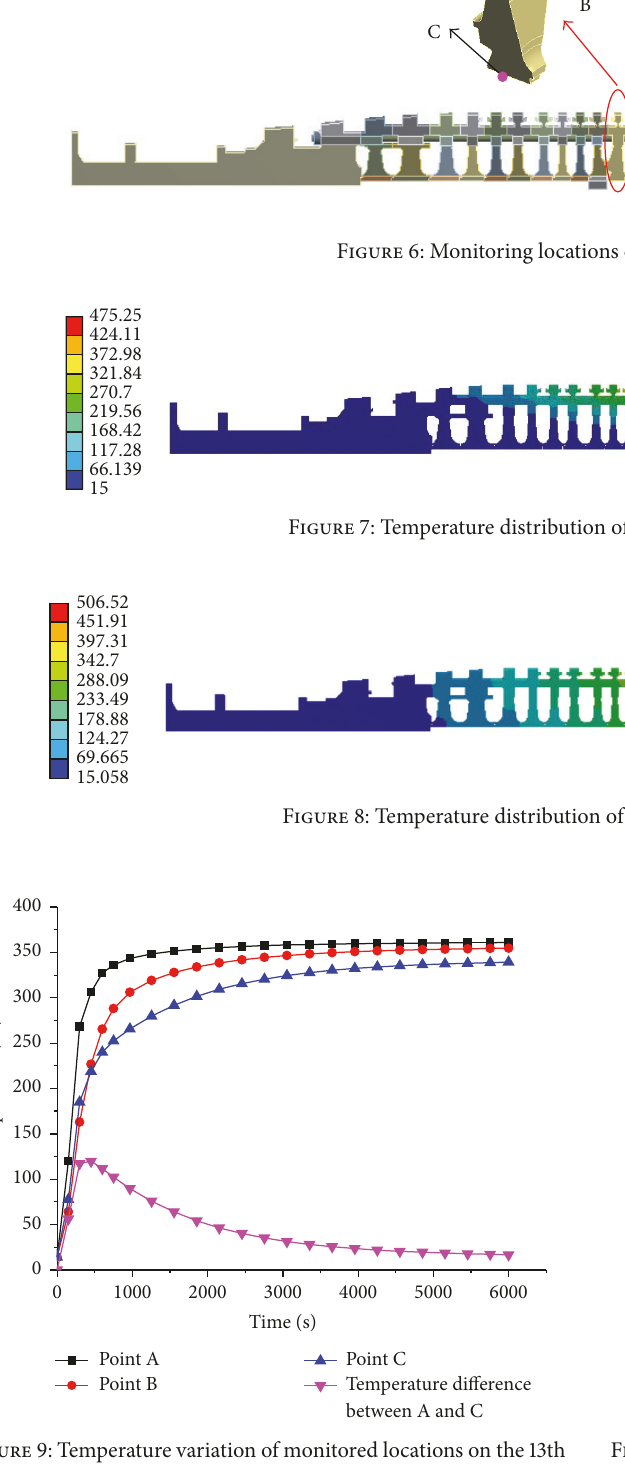
Figure 9: Temperature variation of monitored locations on the 13th compressor disc during start-up period.